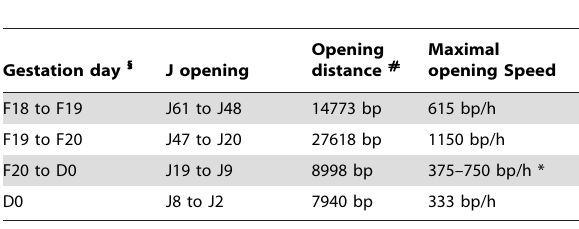
Table 2. J locus accessibility: J genes seen rearranged to V19 during